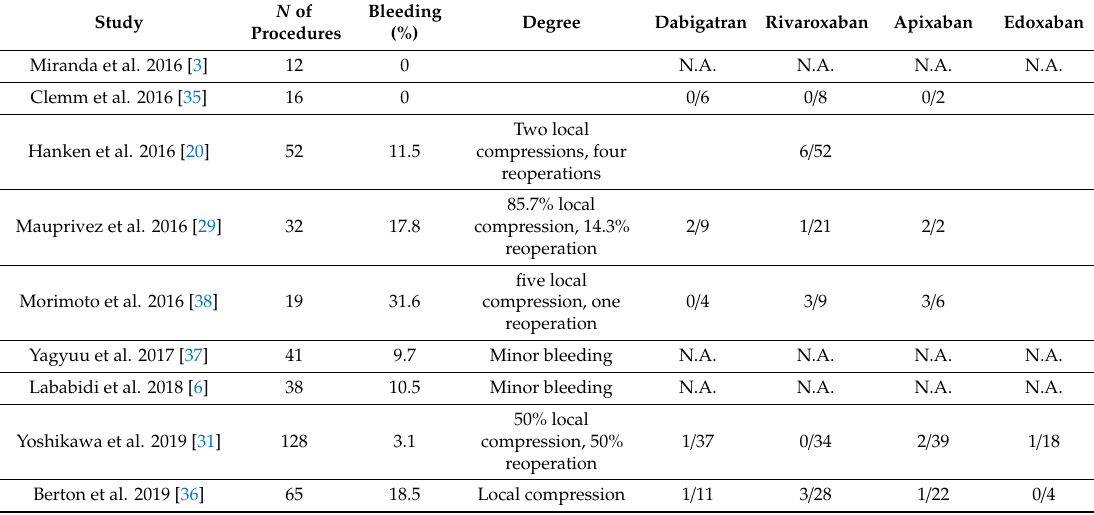
Table 7. Frequency and severity of bleeding in previously published clinical